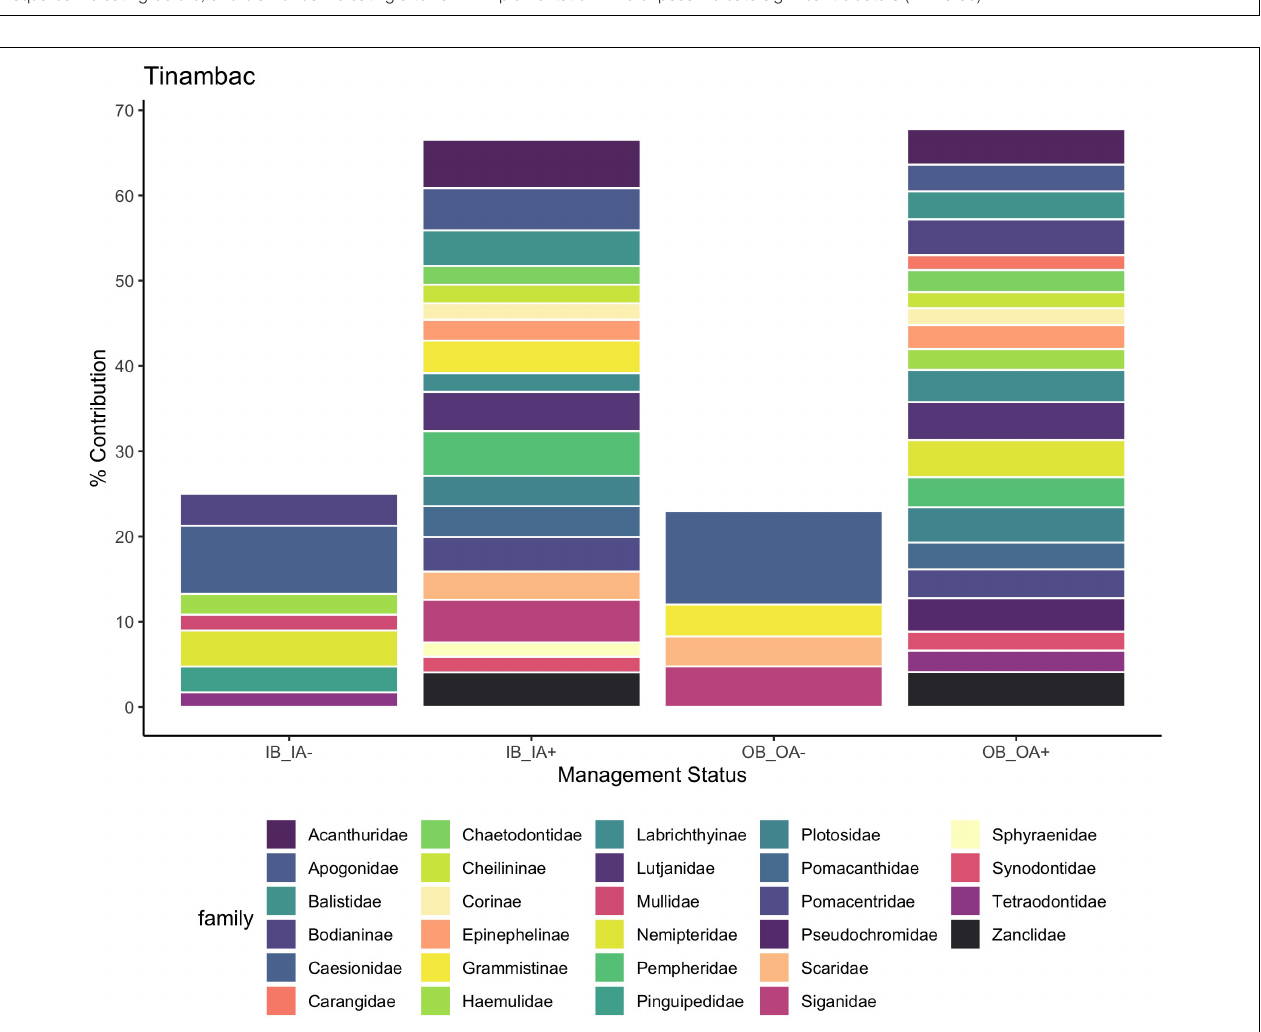
FIGURE 6 | Percent contribution to the dissimilarity between inside before and after (average dissimilarity 31.86) and outside marine reserves before and after (average dissimilarity 31.80) CBM in Tinambac, aggregated by family. OA, outside marine reserve; after CBM implementation; OB, outside marine reserve; before CBM implementation; IA, inside marine reserve; after CBM implementation; IB, inside marine reserve; before CBM implementation. + means that there was higher abundance after CBM, – means there was lower abundance after CBM.